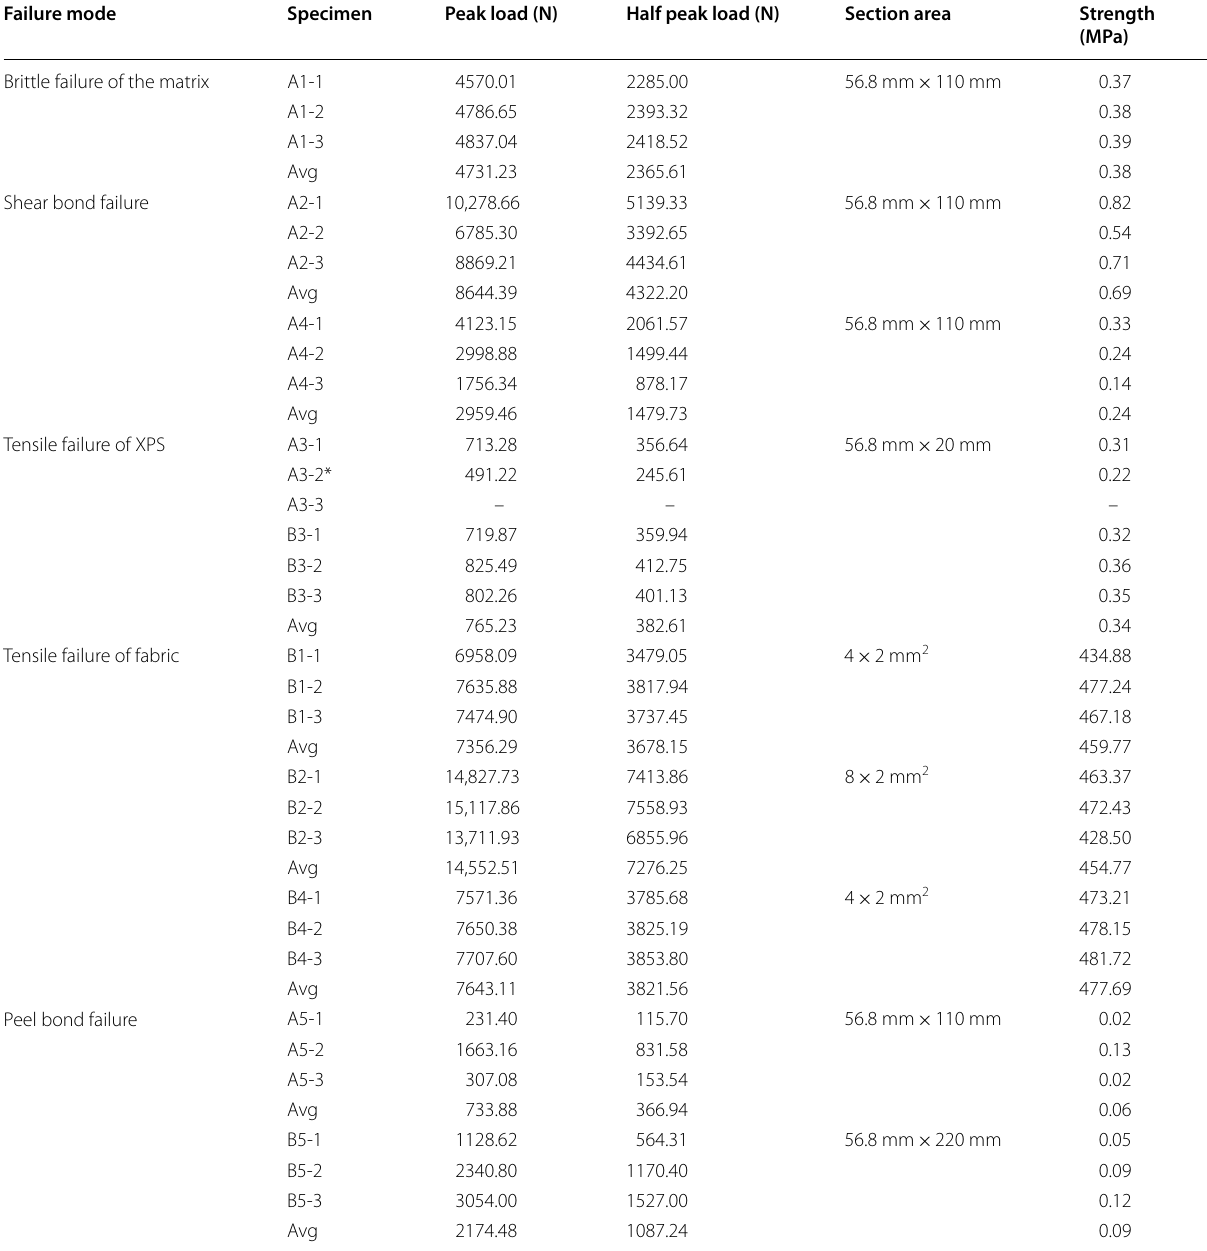
* Denotes invalid data because the XPS plate was corroded by glue – Denotes lost data because the specimen was damaged during